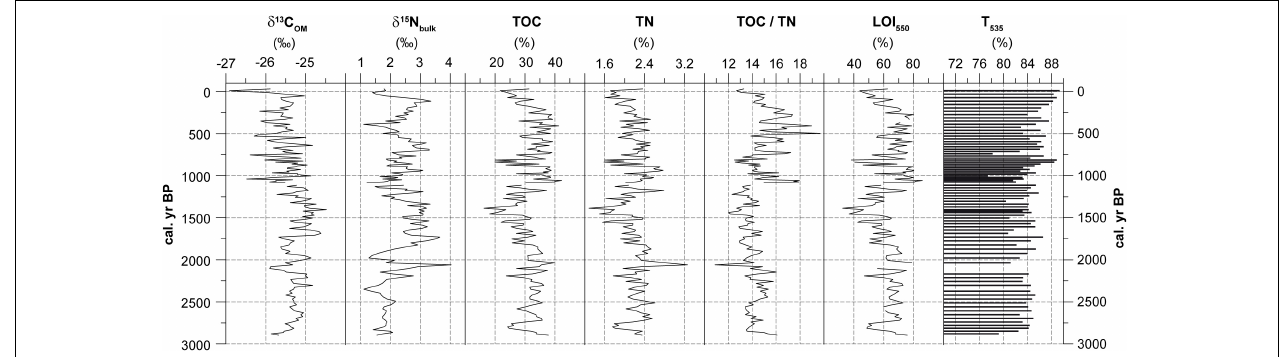
FIGURE 4 | Stable isotopes and element composition on bulk material. δ 13 C OM